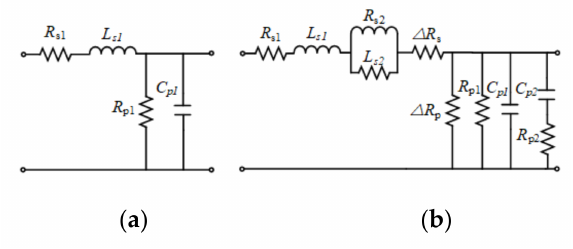
Figure 1. Elementary cell of the cable